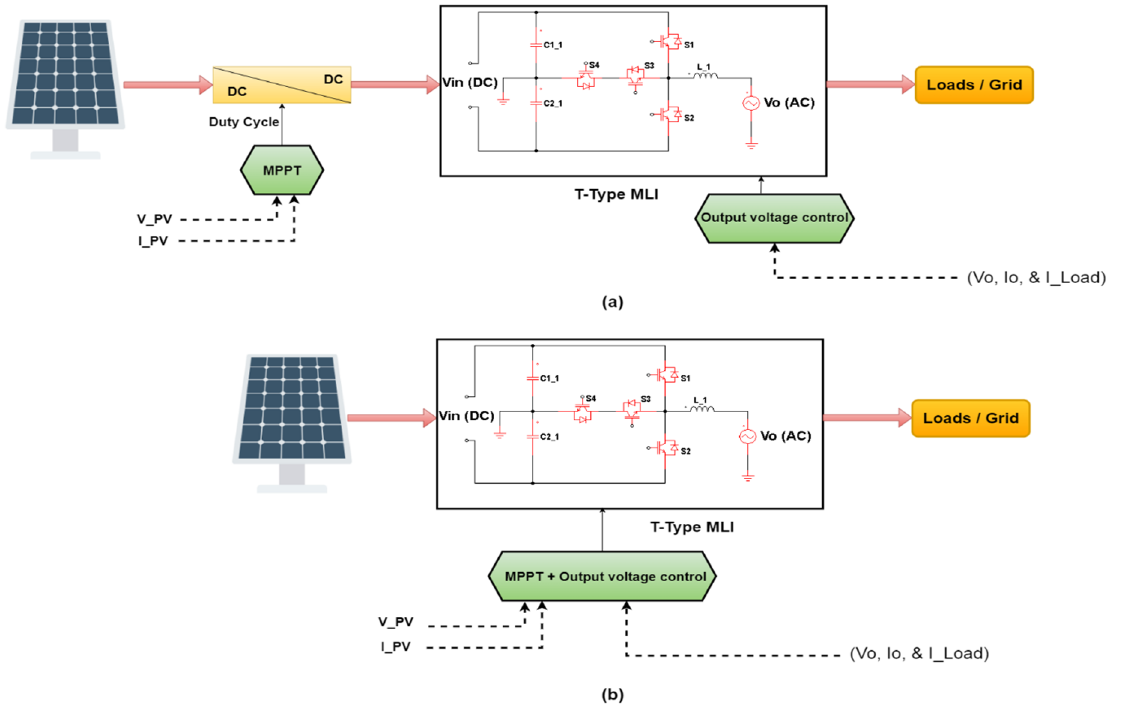
Figure 21. Connection of T-MLI to RES by: ( a ) two stages ( b ) a single